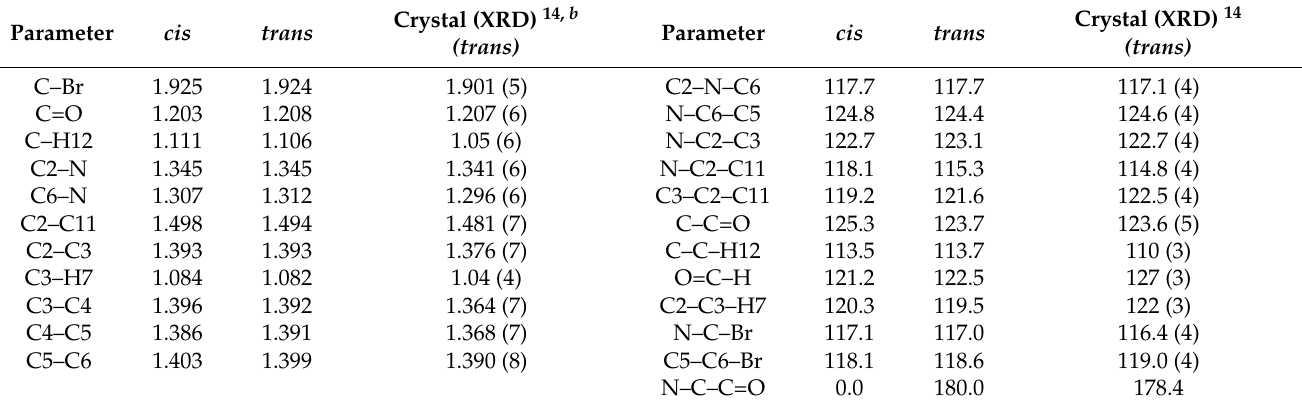
Table 1. B3LYP/6-311++G(d,p) calculated selected geometrical parameters for the two conformers of BPCA and the corresponding observed values in the crystal of the compound a